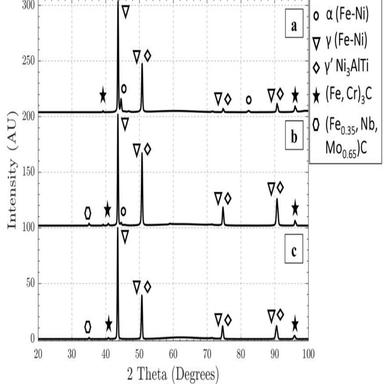
Phases of mixed compositions DED specimens. a) 50% SS420–50% IN718, b) 75% SS420–25% IN718, c) 25% SS420–75% IN718.